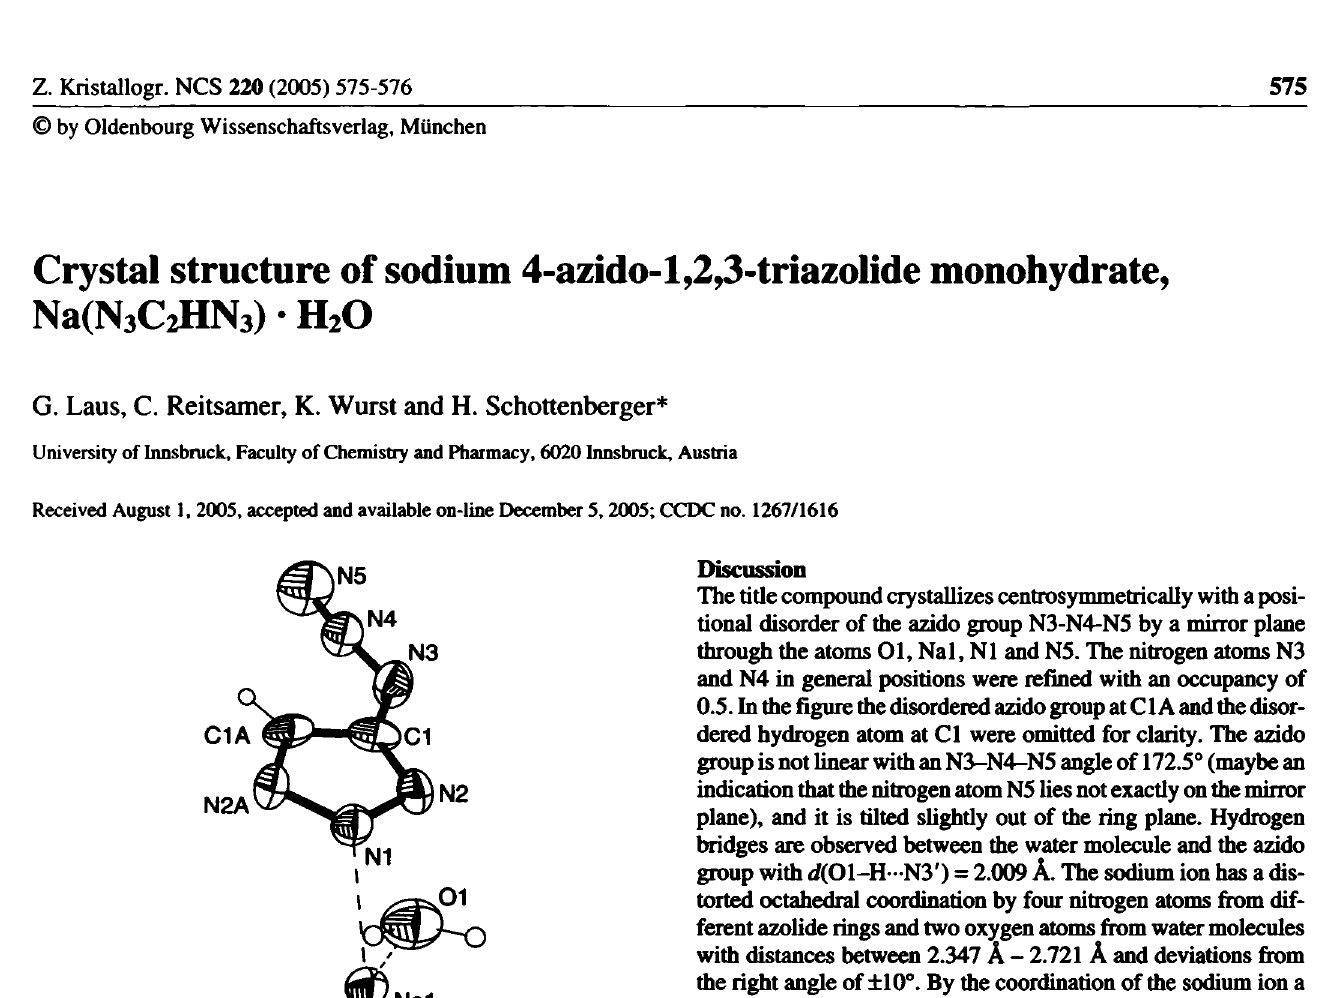
Table 1. Data collection and handling.